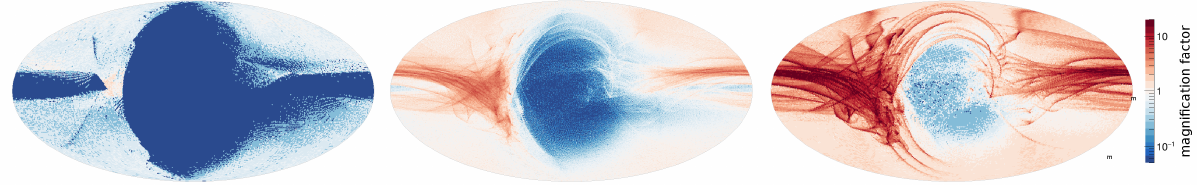
Figure 5. Minimum (left), average (middle) and maximum (right) magnification factor of the 20 GMF models studied in this work at a rigidity of 10